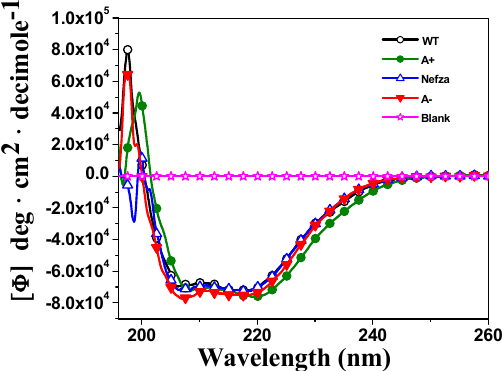
Figure 7. Structural characterization of recombinant human G6PDs enzymes. Circular Dichroism (CD) spectra in the far-UV region of recombinant human G6PD variants. The experiments were performed in triplicate; standard errors were less than 4%.